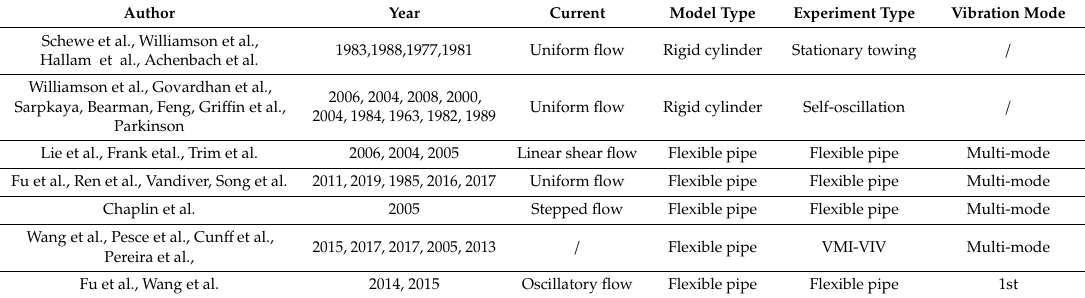
Table 1. Summary of experimental studies on the Vortex-induced Vibration (VIV)